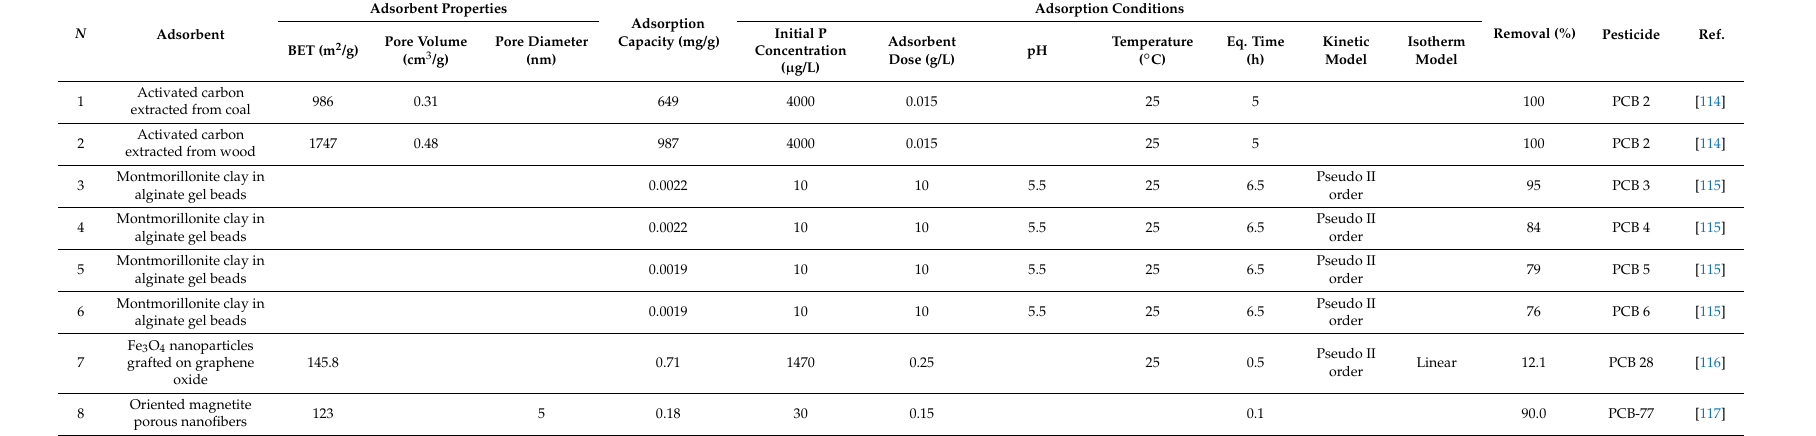
Table 19. Nanofibrous adsorbent properties and adsorption conditions for the removal of PCBs.